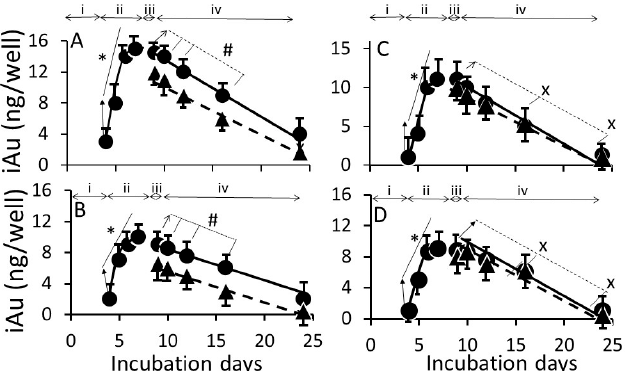
Figure 6. The time course of change in intracellular AuNP KG-50 ( A ), AuNP K-50 ( B ), AuNP G-50 ( C ), and AuNP PEG+K+G ( D ) concentrations in Ap/En cells (solid line) and Ap/Ep cells (broken line). x: p < 0.05 when day 8 (before ethanol/matrix exposure) values were compared with post-ethanol values. #: p < 0.05 when corresponding Ap/En values were compared with corresponding An/Ep values. Please define *: p < 0.05, significant, when compared with the lowest value from the same group. Abbreviations: i: three days of cell growth (days 1 to 3); ii: four days of AuNP or matrix pretreatment (day 4 to day 7); iii: 24 h ethanol or saline (matrix) exposure (day 8) and iv: AuNP and ethanol free media for 16